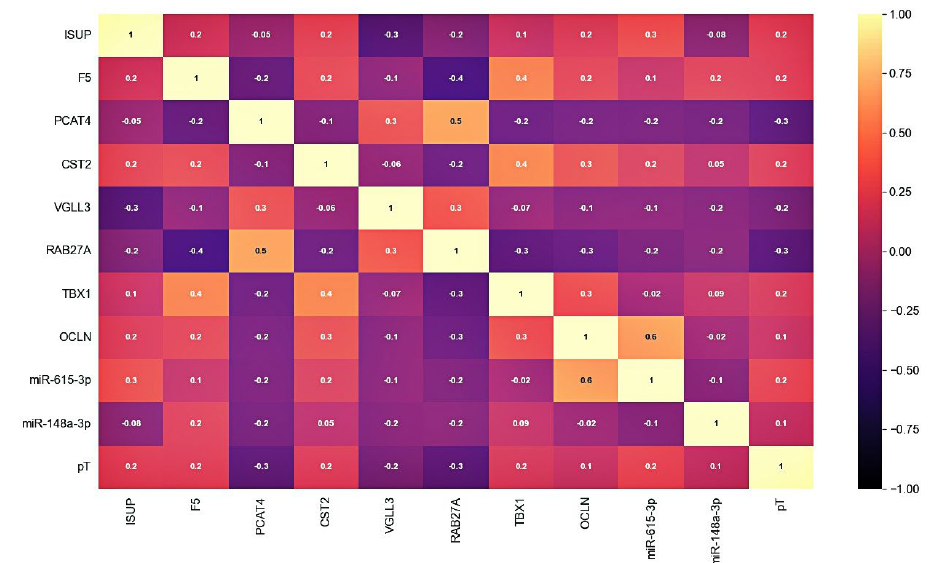
Figure 2. Correlation matrix of candidate markers and clinicopathological parameters expression levels. Cell colors correspond to the value of the Pearson correlation coefficient.